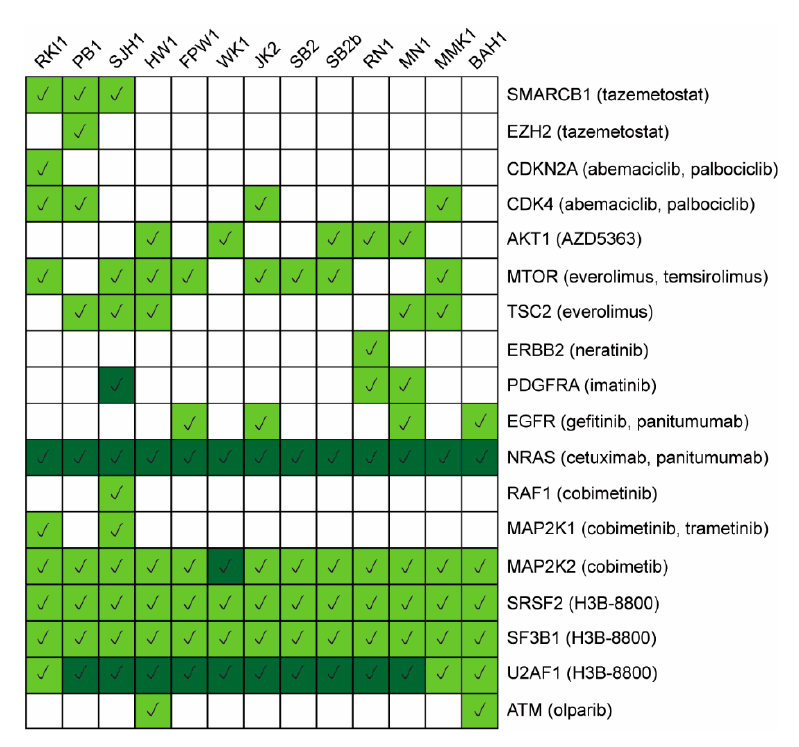
Figure 6. Protein expression matrix of targetable proteins. Expression levels (high, dark green; medium to low, light green; white, not detected) of proteins with potential FDA-approved drugs extracted from the OncoKB knowledgebase.